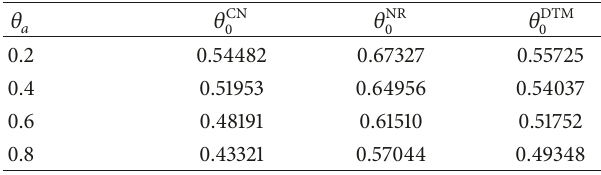
Table 1: Temperature at 𝑟 = 0 for varied values of 𝜃 𝑎 .